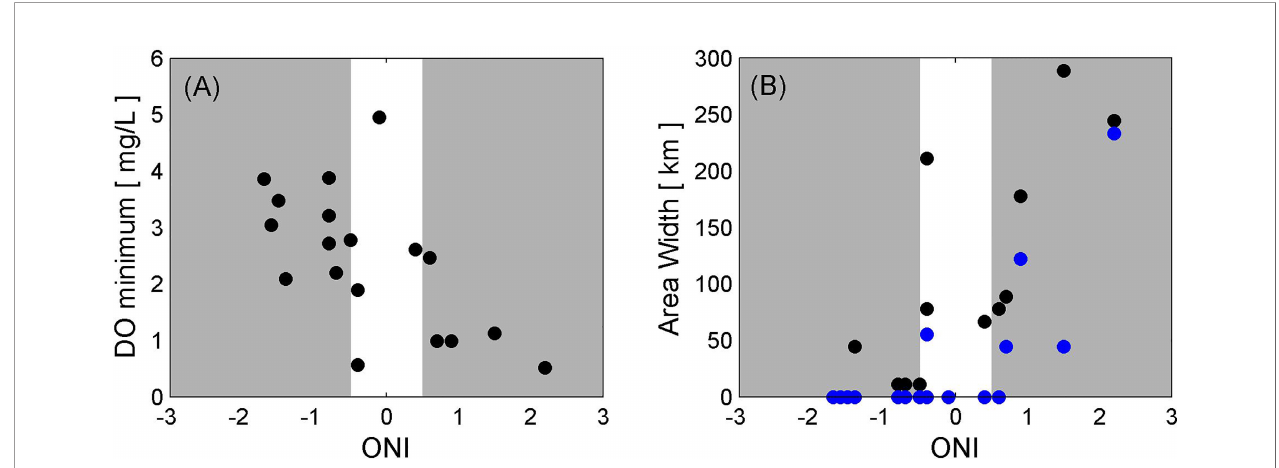
FIGURE 10 | (A) Scatter plot of DO minimum along Section C-C during 1997 – 2014 and associated ONI in January. (B) Same as (A) , but for the width of low- oxygen area (black dots) and hypoxia area (blue